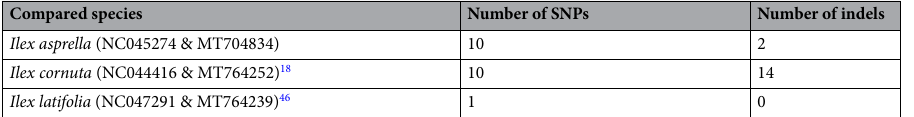
Compared species Number of SNPs